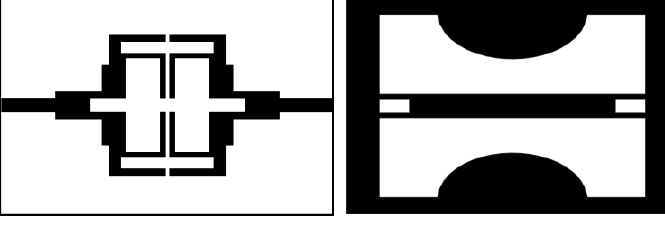
FIGURE 3. Geometry and simulation of the second filter design (a) Top and bottom view, (b) S-parameters.